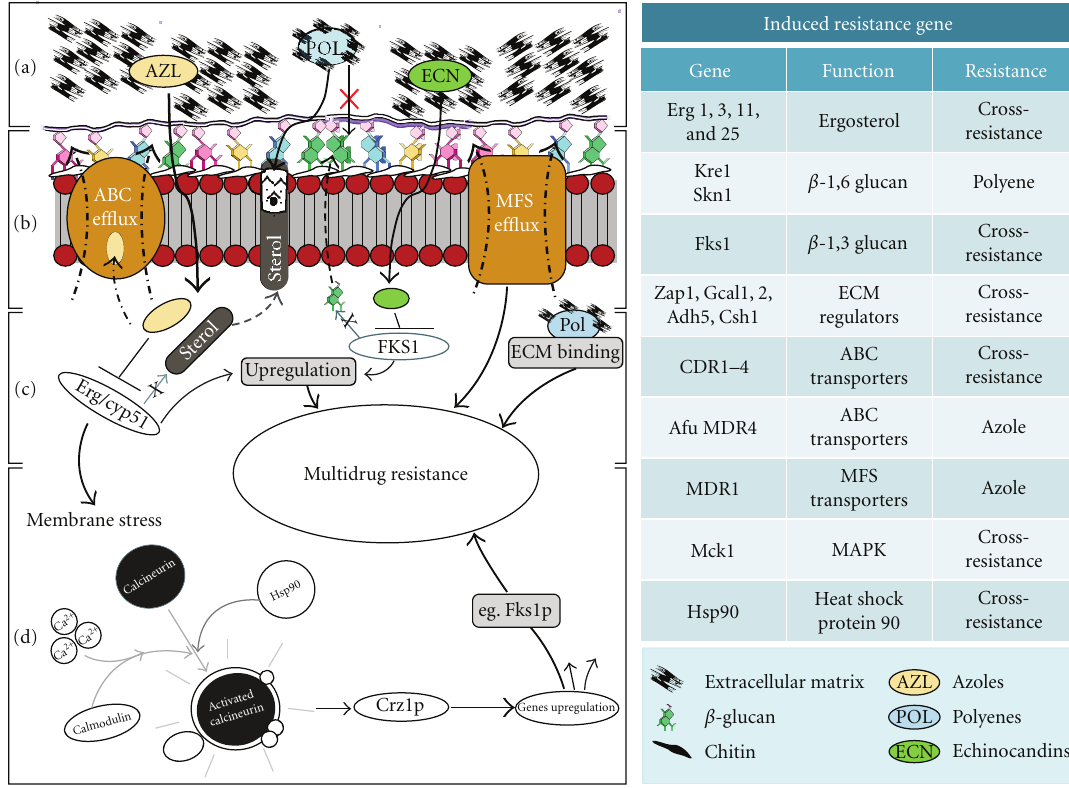
Figure 2: Molecular mechanisms of fungal biofilm resistance. Antifungal drug resistance in fungal biofilms is both complex and multifactorial. The diagram illustrates the mechanisms of di ff erent class of antifungal agent action (azoles [AZL], polyenes [POL], and echinocandins [ECN]) and resistance: (a) the layer of ECM present in the biofilm shields the cells from antifungal agents by binding and reduced penetration; (b) the membrane transporter system ABC and MFS e ffl ux pumps extrude antifungal molecules and reduce the intracellular concentration; (c) mutation in ERG , Cyp51, and FKS1 genes alters the drug target leading to cross-resistance; (d) antifungal pressure induces stress responses, such as the calcineurin signalling pathway, which is activated, and coping responses occur through upregulation of various signal transducers. On the right hand side, the table lists di ff erent resistance genes and their functions, and antifungal agents a ff